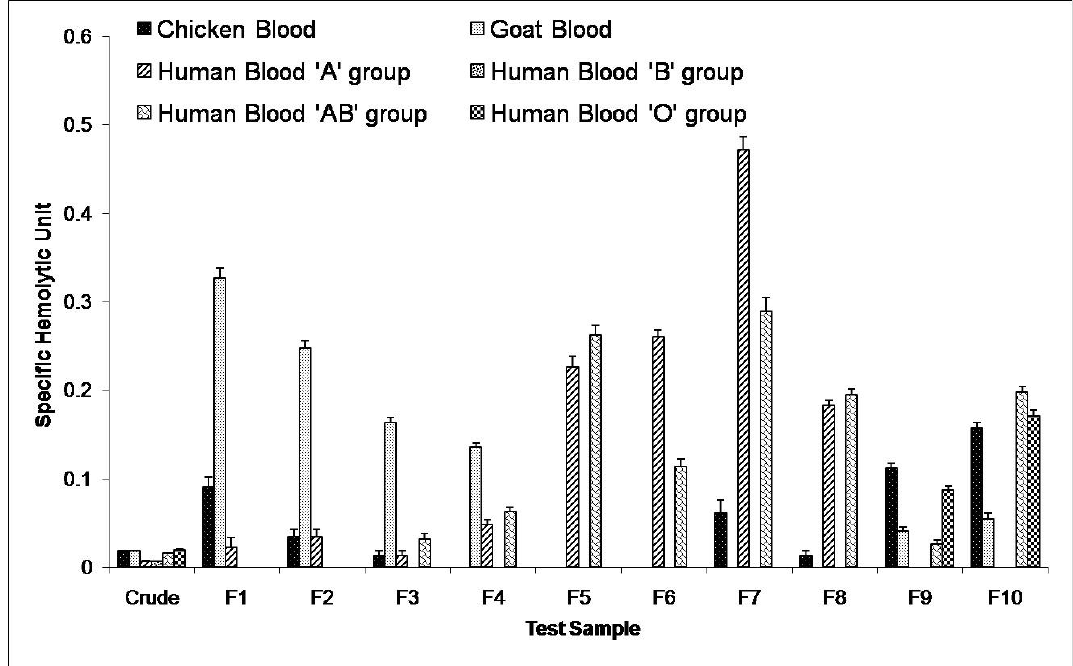
Figure 1. The extent of in vitro hemolytic activity of Stellaster equestris crude toxin (fractions F1 to F10) on chicken, goat and human